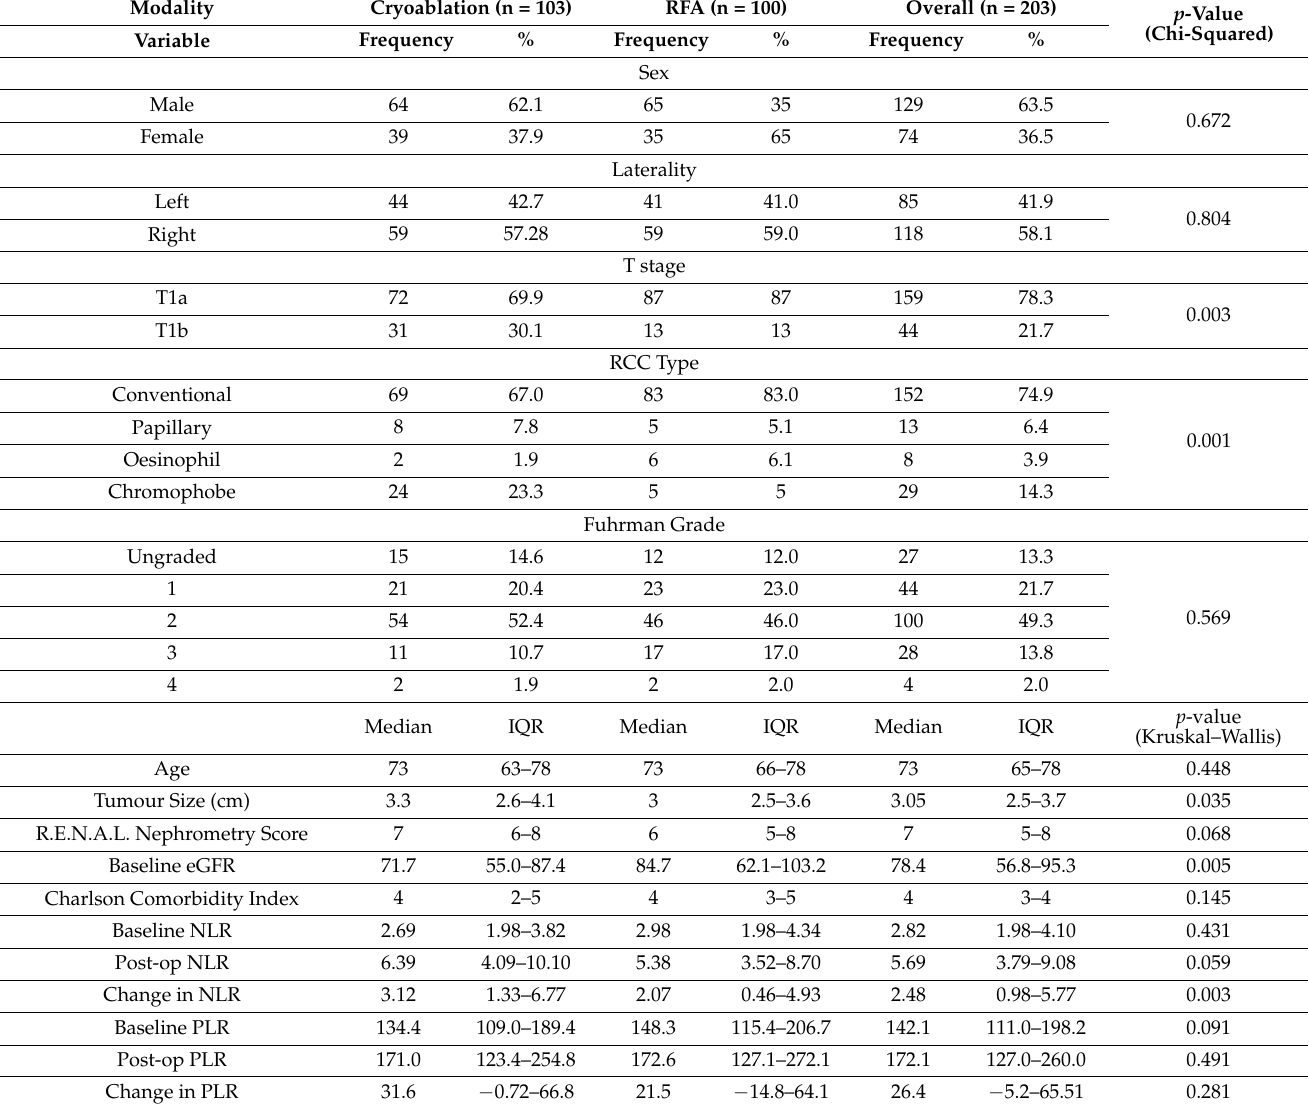
Table 1. Baseline characteristics of included